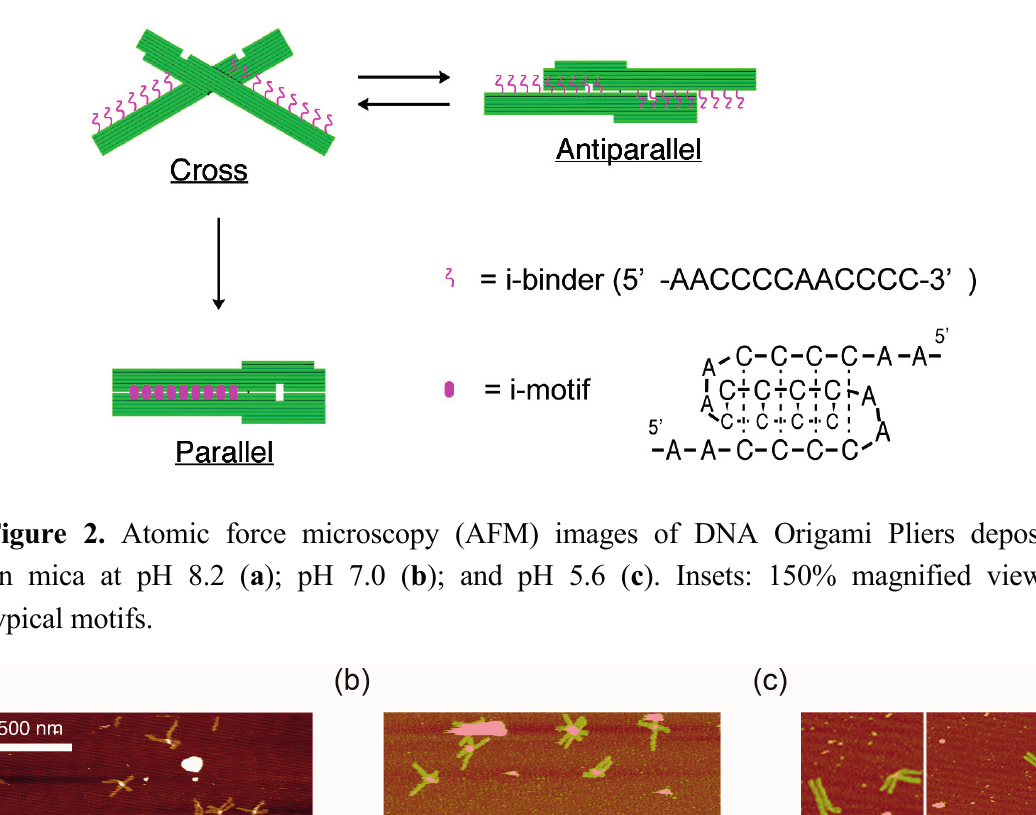
Figure 1. Schematic illustration of the present system. Under acidic conditions, nine pairs of 12-mer i-binders (5'-AACCCCAACCCC-3') attached to the levers of DNA Origami Pliers form i-motif quadruplexes by protonation of the cytidines.